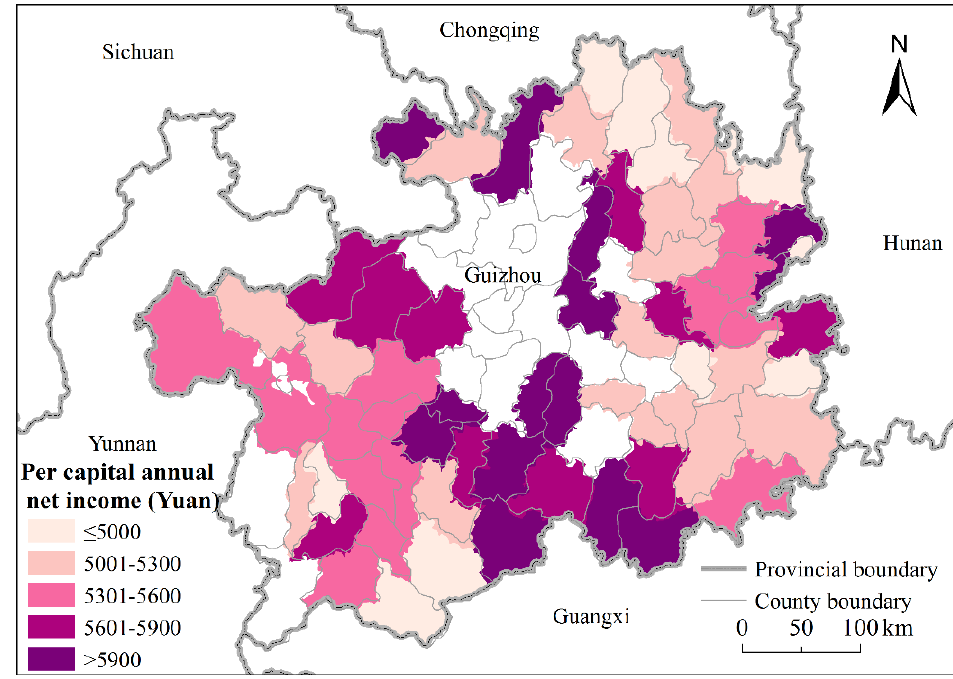
Figure 1. Location of the study area. ( a ) Spatial distribution of poverty-stricken areas. ( b ) Location of Guizhou Province and its neighboring poverty-stricken areas. .